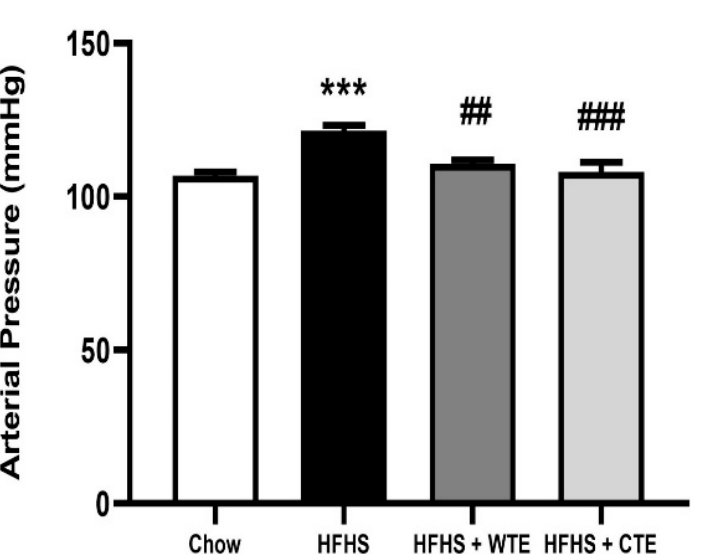
Figure 4. Mean arterial pressure of mice fed a standard diet (Chow), a high-fat diet/sucrose diet (HFHS), or high-fat diet/sucrose diet supplemented with White Tea Extract (HFHS + WTE), or high-fat diet/sucrose diet supplemented with Tea Complex Extract (HFHS + TCE). *** p < 0.001 vs. chow. ## p < 0.01; ### p < 0.001 vs. HFHS. The values are represented as the mean ± S.E.M; n = 7–10 samples/experimental group.